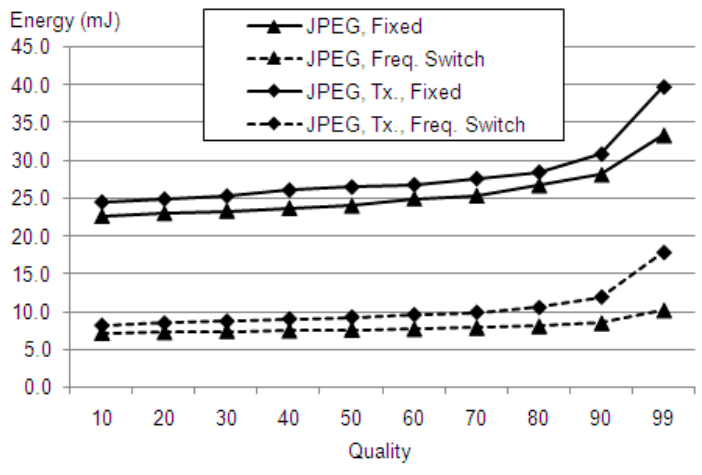
Figure 8 . Energy consumption of JPEG compression versus quality .